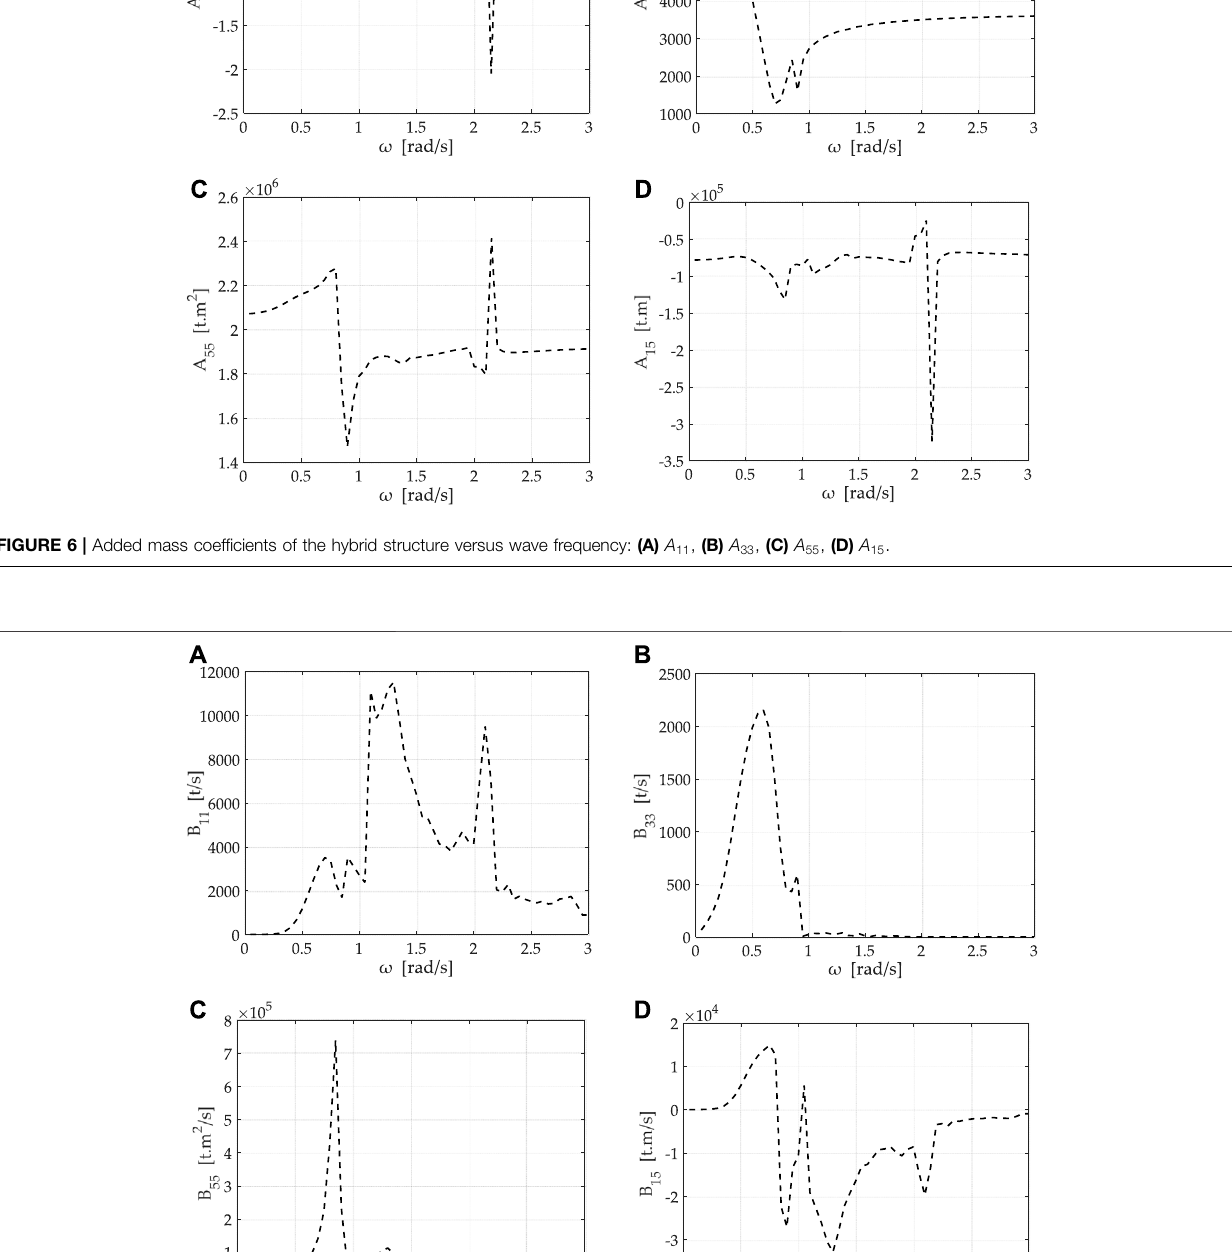
Frontiers in Energy Research |